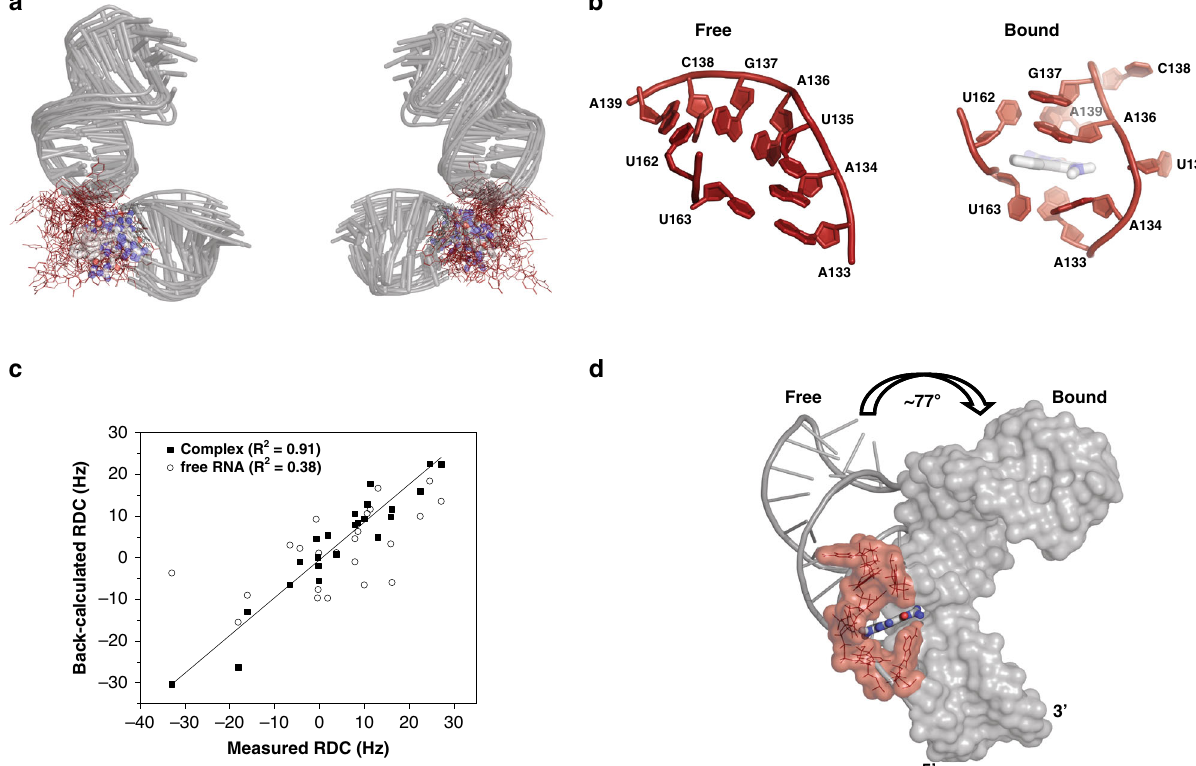
Fig. 5 DMA-135 changes the local and global structure of SLII. a Superimposition of 10 lowest energy SLII-(DMA-135) complex structures re fi ned in AMBER using NOE-derived distance restraints and RDCs. The overall RMSD for the stably base paired regions is 2.4 Å. b Comparison of the bulge stacking interactions of (left) free SLII to that of the SLII-(DMA-135) complex (right). c Correlation plot between measured and back-calculated RDCs from a representative low energy SLII-(DMA-135) structure and to back-calculated RDCs from the free SLII structure. d Superimposition of the lower helices of free and bound SLII reveals that DMA-135 induces a global change to the SLII